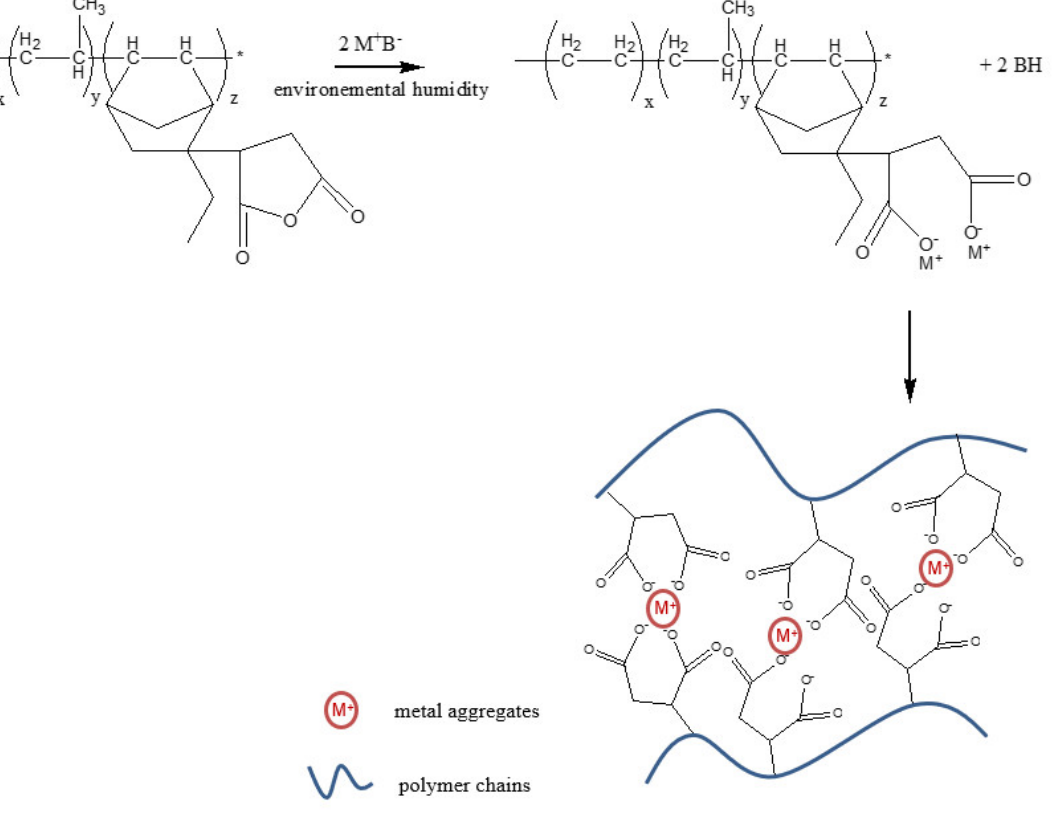
Figure 2. Variation of the compression set ( ■ ) and the gel fraction (●) for the EPDM-g-MA crosslinked with different DCP concentration (wt.%). No metallic salt has been added in these formulations.